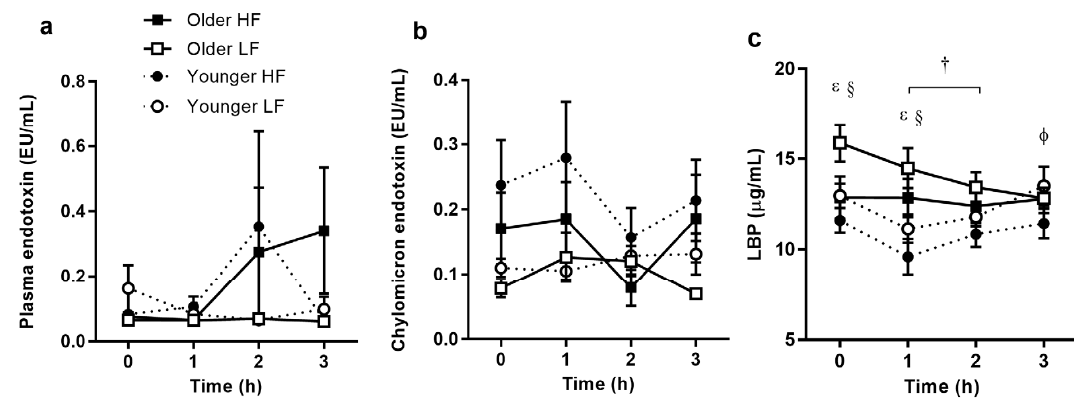
Figure 2. Endotoxin and lipopolysaccharide binding protein (LBP) responses to high-fat (HF) and low-fat (LF) breakfasts in older and younger subjects. Older high-fat ( filled squares ), older low-fat ( open squares ), younger high-fat ( filled circles ), younger low-fat ( open circles ). Values represent mean ± SEM in EU/mL for plasma endotoxin (( a ); n = 12/group) and chylomicron endotoxin (( b ); n = 12/group) and in µ g/mL for LBP (( c ); n = 15/group). There were no differences in plasma or chylomicron endotoxin responses between older and younger subjects. There were significant differences in the LBP response over time, dependent on age and treatment (age × time × treatment interaction of p < 0.05, three-factor repeated-measures ANOVA). ε p < 0.05 age difference after LF; § p < 0.05 treatment difference in older subjects; φ p < 0.05 treatment difference in younger subjects; † p < 0.05 time difference after LF in older subjects (Sidak corrected post hoc